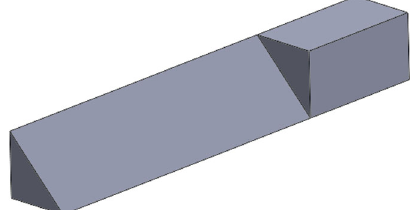
FIG. 1. An example right angle triangle magnet.